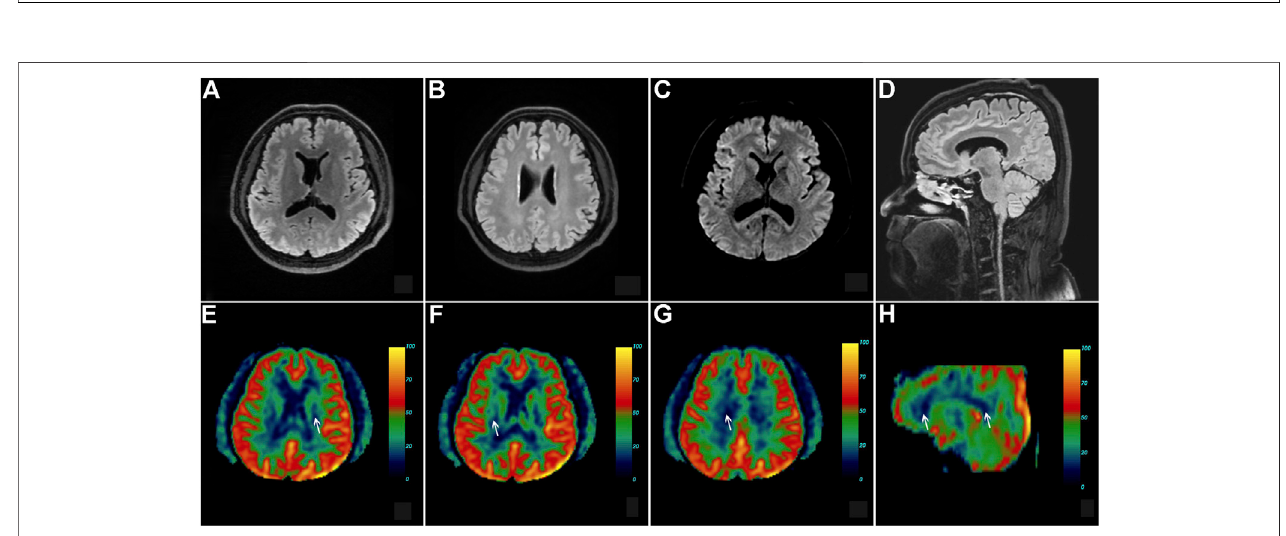
FIGURE5| Brainneuroimaging oftheproband ’ sbrother (patientIII-11) inthe fi rstfamily.Brain FLAIR demonstrates fewslight hyperintensitiesintheperiventricular white matter (A,B) and a focal high signal in the body of the corpus callosum (D) . There is no abnormal signal in the axial diffusion-weighted imaging (C) . Brain pseudo- continuousarterialspinlabelingrevealedamarkedreductionofthecerebralblood fl ow(CBF)inthebilateraldeepandsubcorticalwhitematteroffrontoparietallobes.The pointvalueoftheCBFintheleftperiventricularareais15.3 ml/100 g/min (E) ,thepointvalueoftheCBFintherightperiventricularareais18.6 ml/100 g/min (F) ,the pointvalueoftheCBFinthesubcorticaldeepwhitematterofparietallobeis8.6 ml/100 g/min (G) ,andthevalueofCBFintheanteriorcorpuscallosumis16.8 ml/100 g/ min (H) , while that in the splenium of corpus callosum is 13.5 ml/100 g/min.